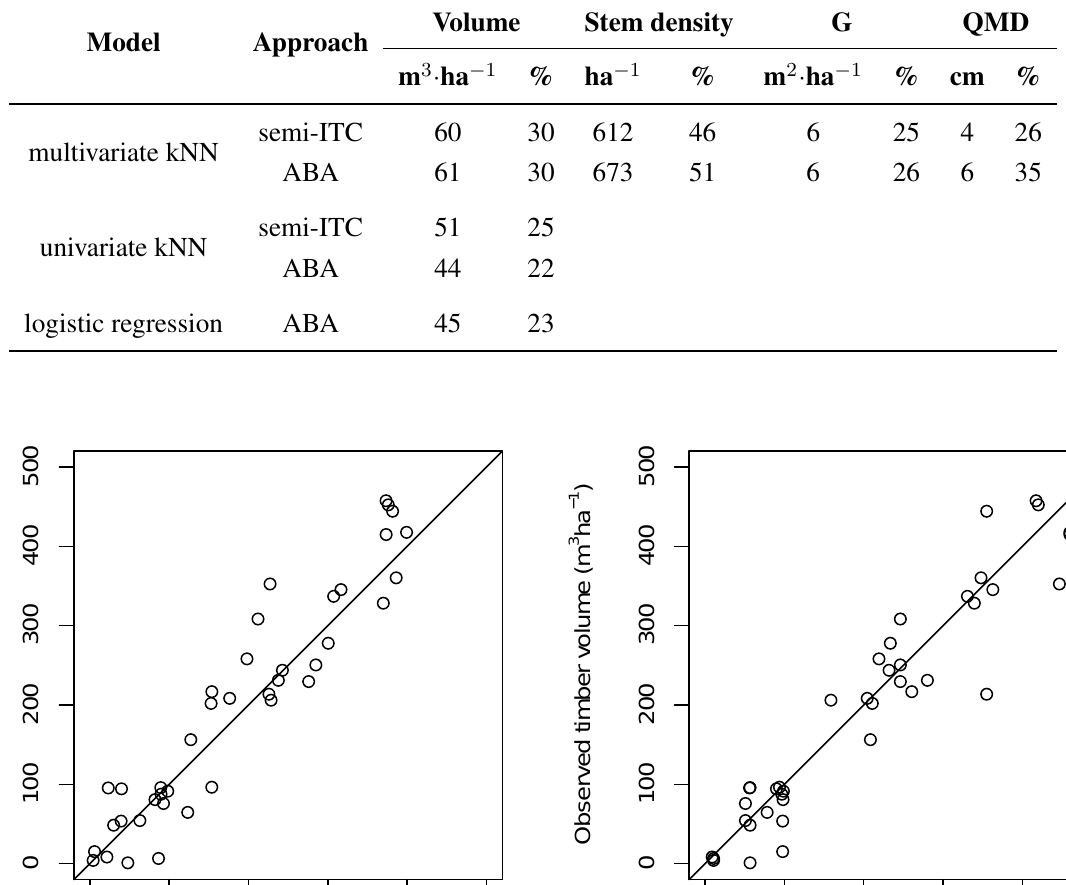
Table 2. RMSEs of the model predictions. G, basal area. QMD, quadratic mean diameter.